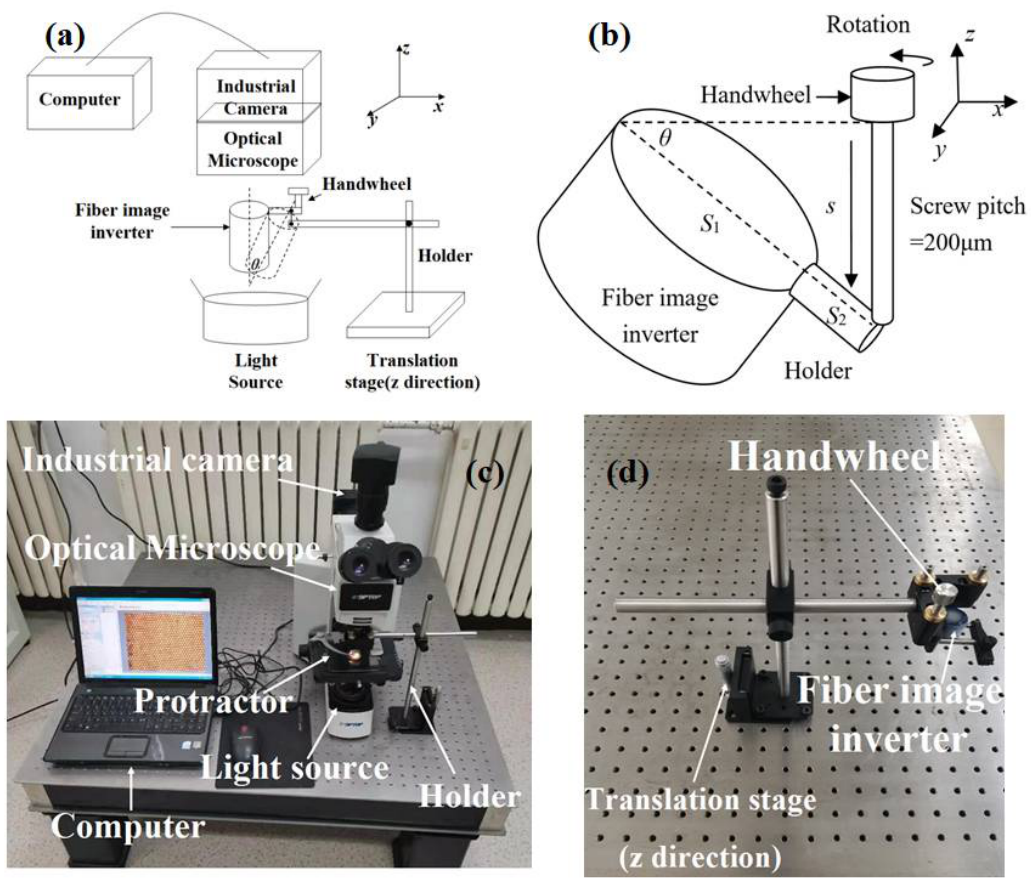
Figure 8. Experimental apparatus and schematic diagram: ( a ) measurement schematic; ( b ) relation between screw extension and slope angle θ ; ( c ) experimental apparatus; ( d ) holder and material.